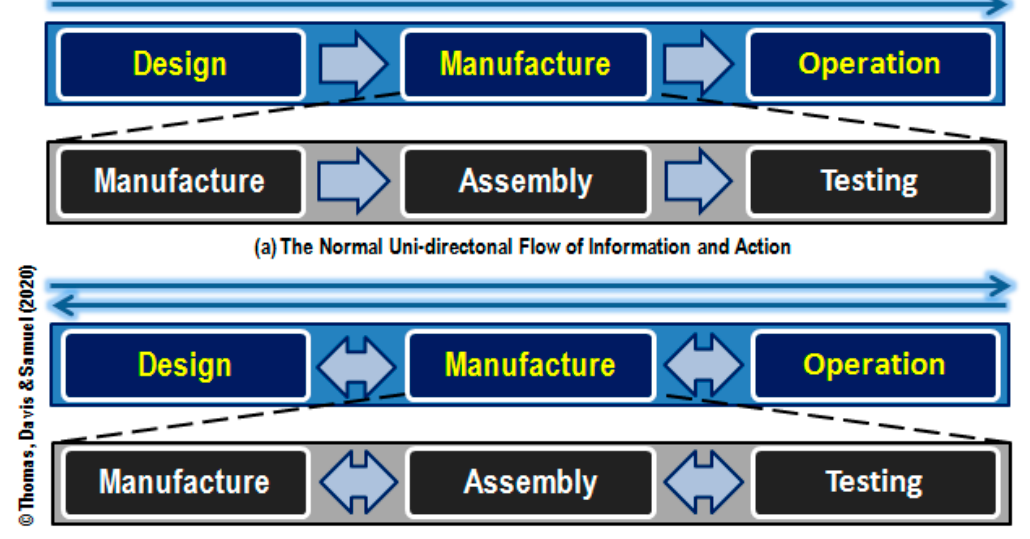
Figure 12. Bi-directional Synthesis along the Axis of Performance.